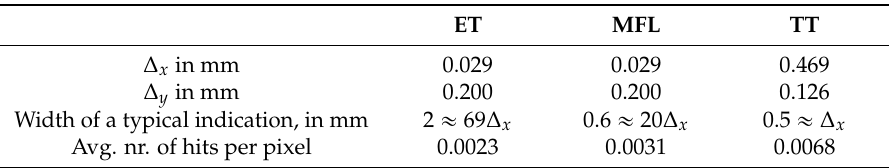
Figure 6. Preprocessed line scan per inspection method around groove nr. 13. ( a ) ET; ( b ) MFL; ( c ) TT. The signals are shifted so that each peak value is located at x “ 0. Note the different intensity scales. Table 2. Quantitative properties of the individual data